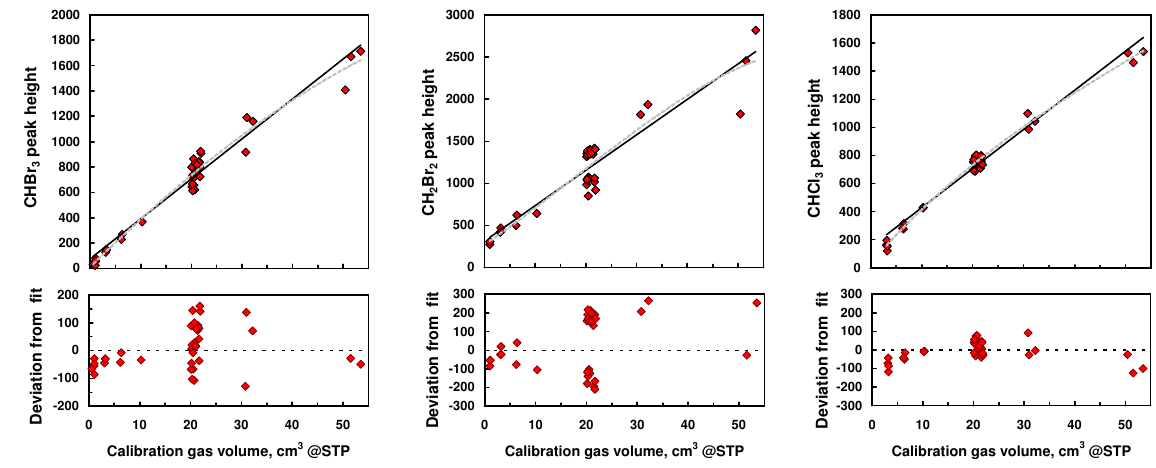
Fig. 6. Typical µ Dirac calibration response curves showing raw peak height versus calibration volume for bromoform (left), dibromomethane (centre) and chloroform (right). Individual calibrations are shown as red diamonds, the solid black line is the linear regression and the dashed grey line is a 3rd order polynomial (used for the non-linearity correction). To highlight any departure from linearity the lower panel for each compound shows the standard deviation from the linear fit of the calibration points and the dotted black line in the lower panels is the linear fit through the deviations. The measurements were made in 2009 (26th June to 3rd July) during remote operation at Bukit Atur,